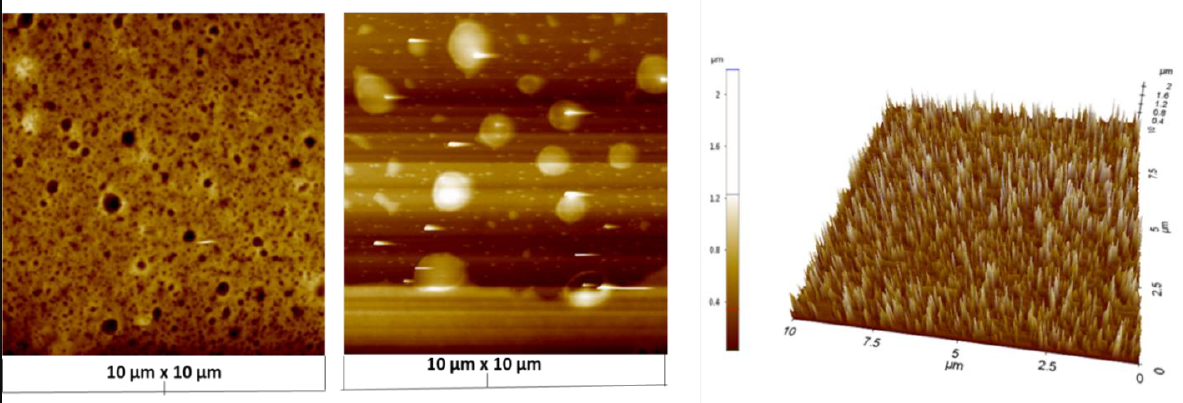
Figure 6. A FM analysis of AgNPs and 3D magnification over 10 μm × 10 μm. Figure 6. AFM analysis of AgNPs and 3D magnification over 10 µ m × 10 µ